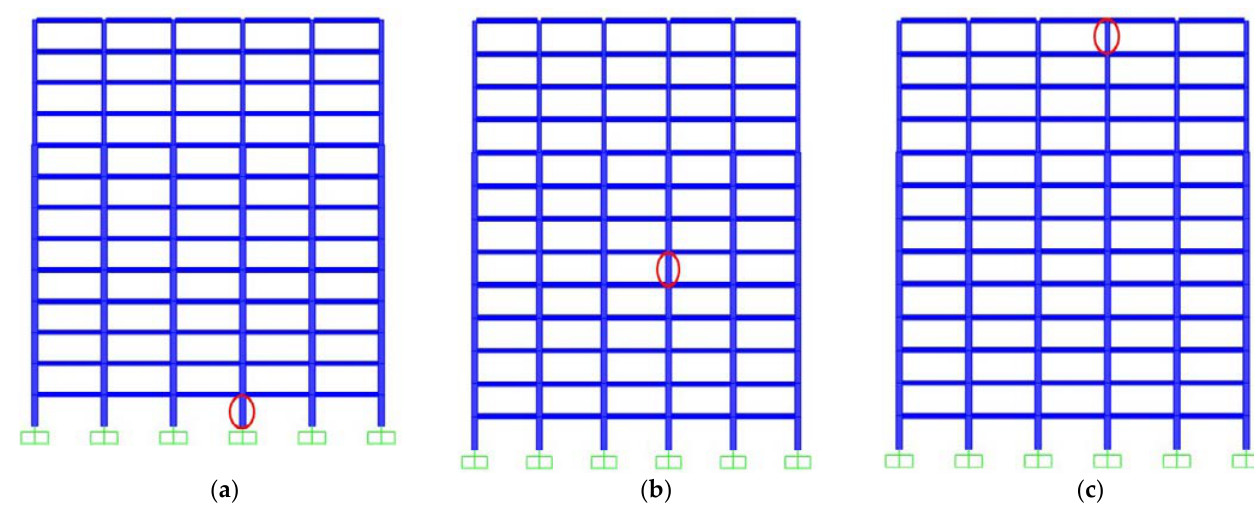
Figure 6. Column removal scenario in ( a ) story one, ( b ) story six, and ( c ) story thirteen.